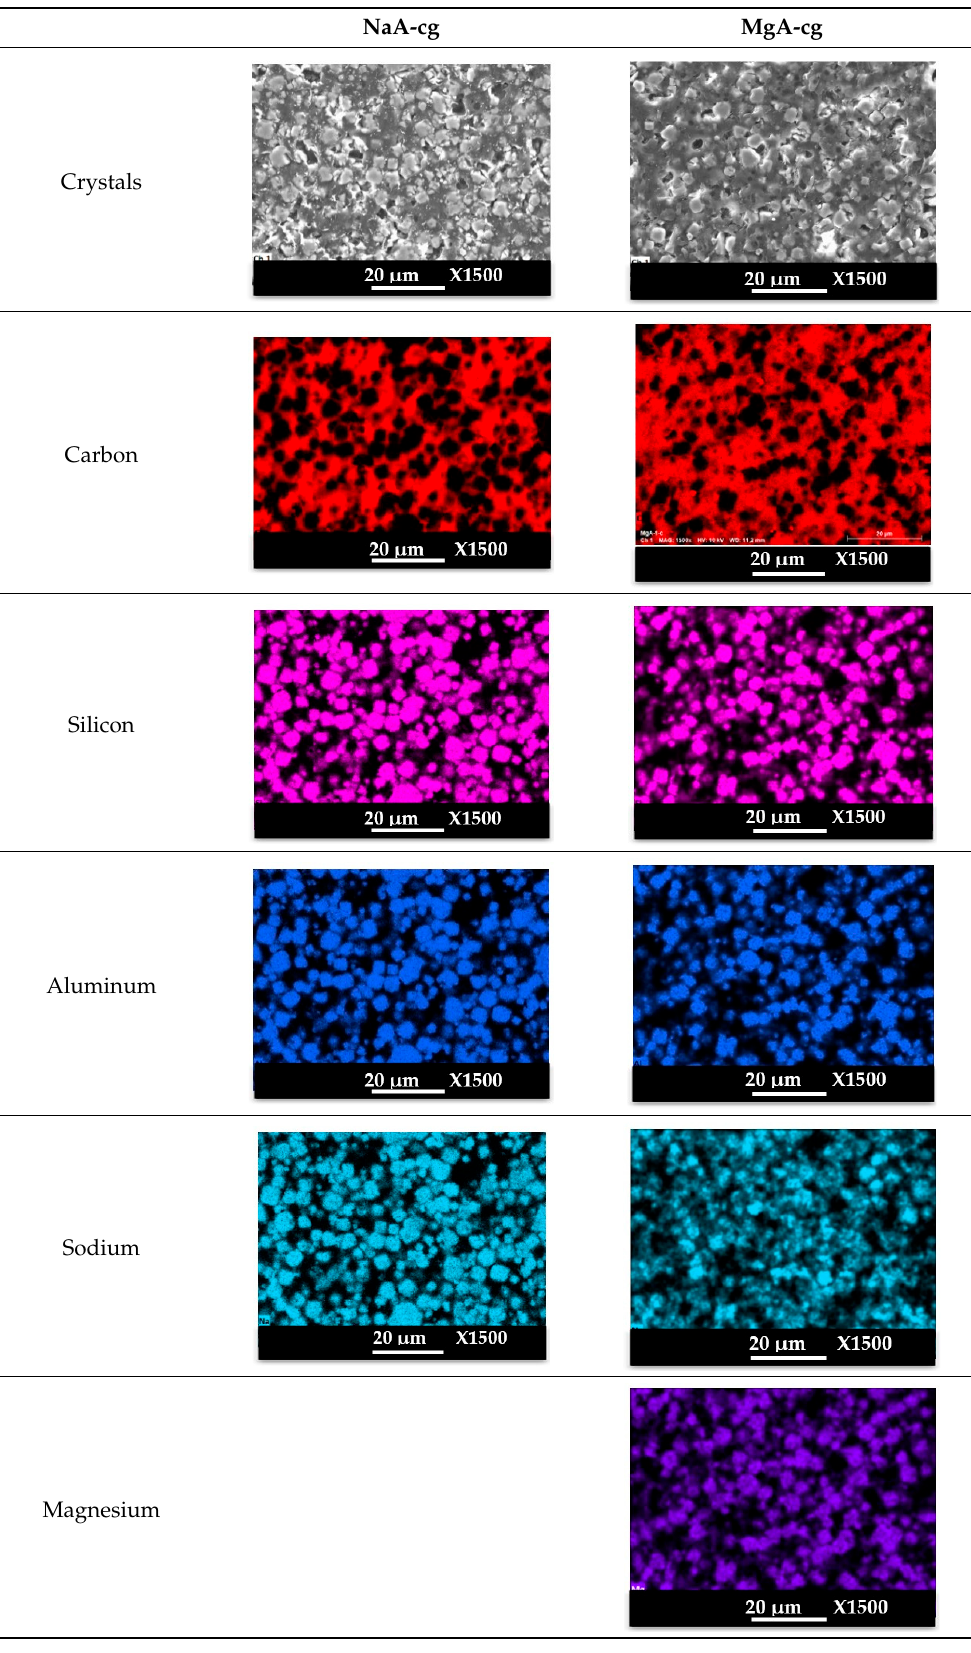
Table 4. EDX mapping of carbon, silicon, aluminum, sodium, and magnesium of the NaA-cg and MgA-cg samples.